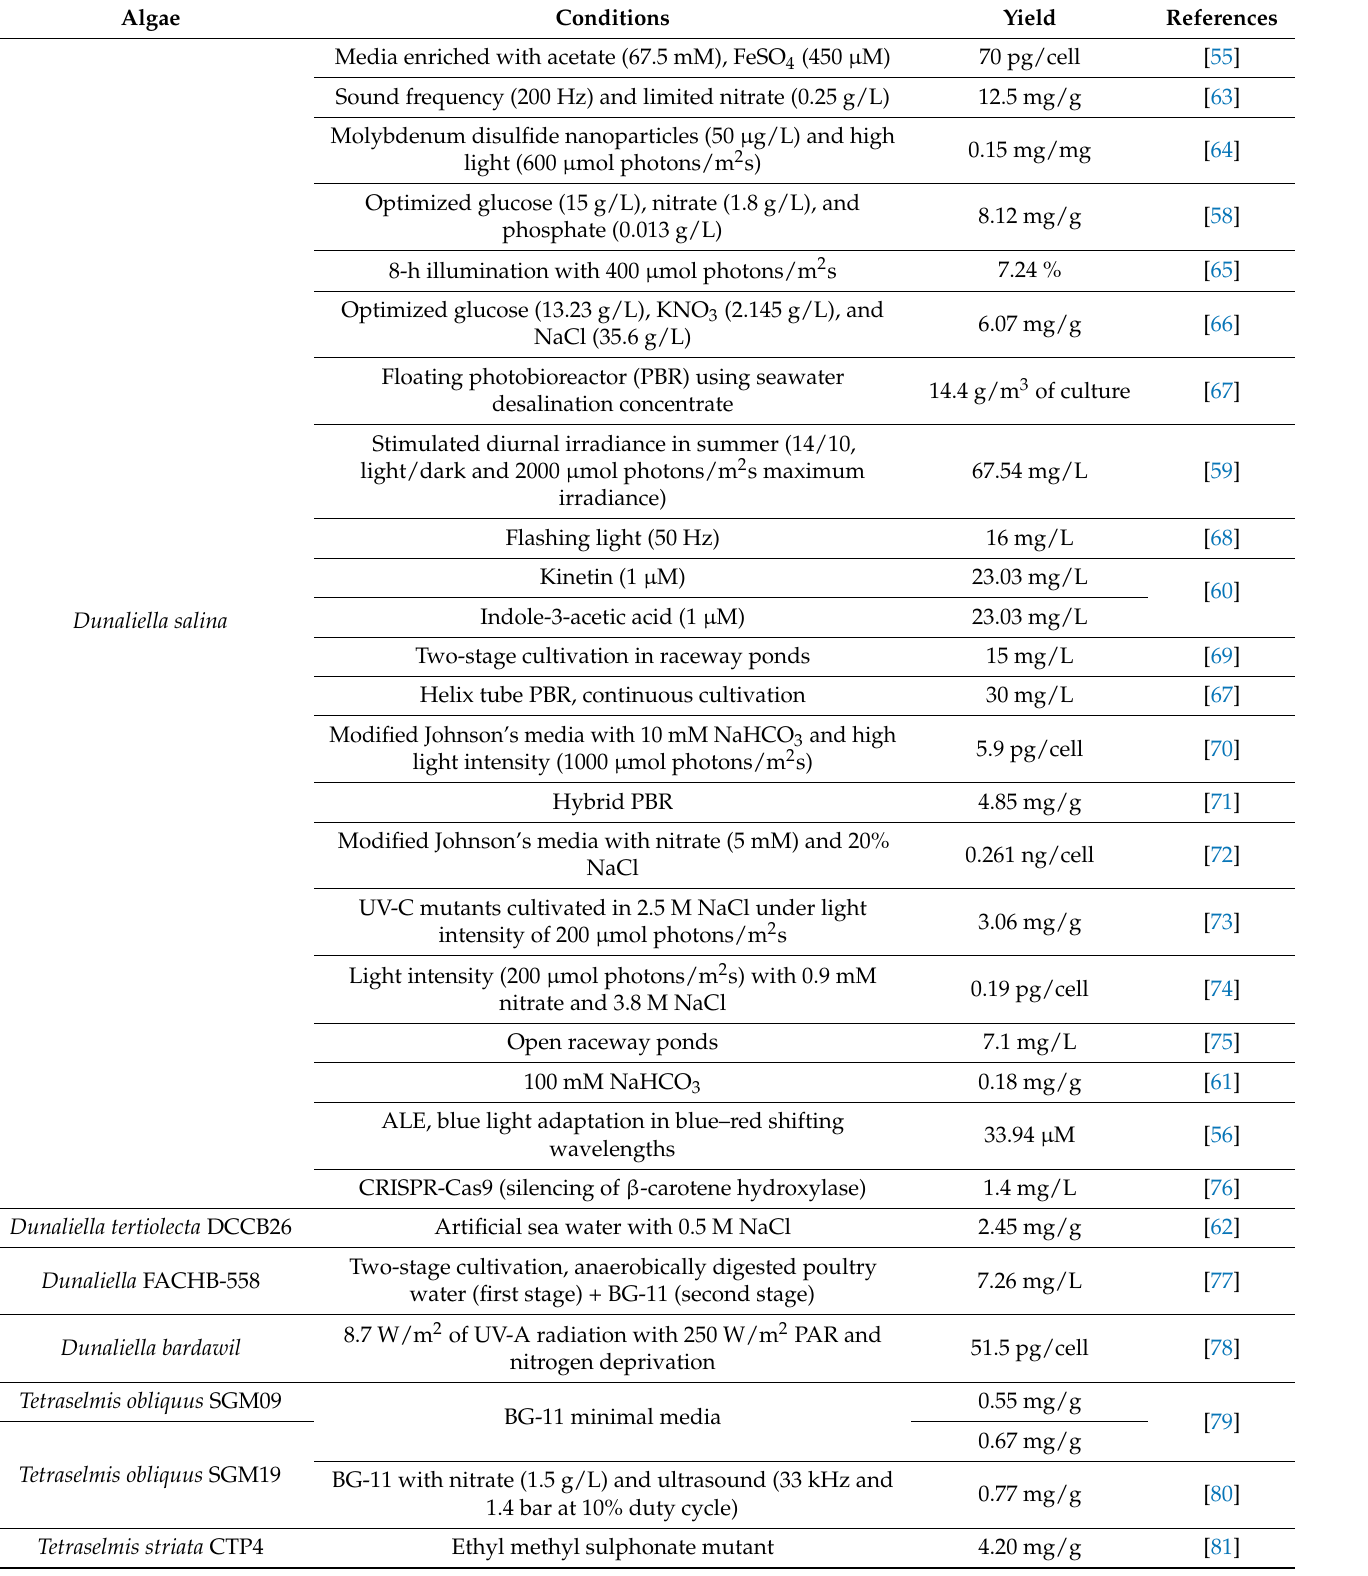
Table 2. Production of β -carotene from algal